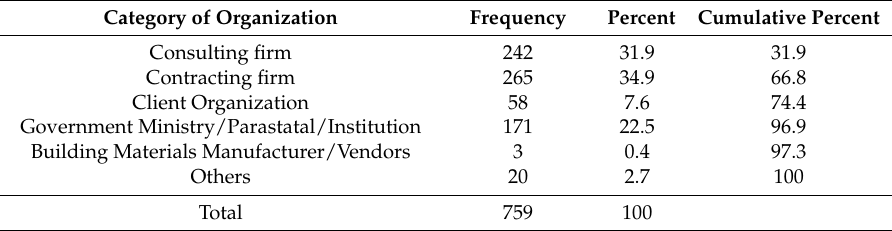
Table 3. Actual users of e-Procurement systems according to organizations.